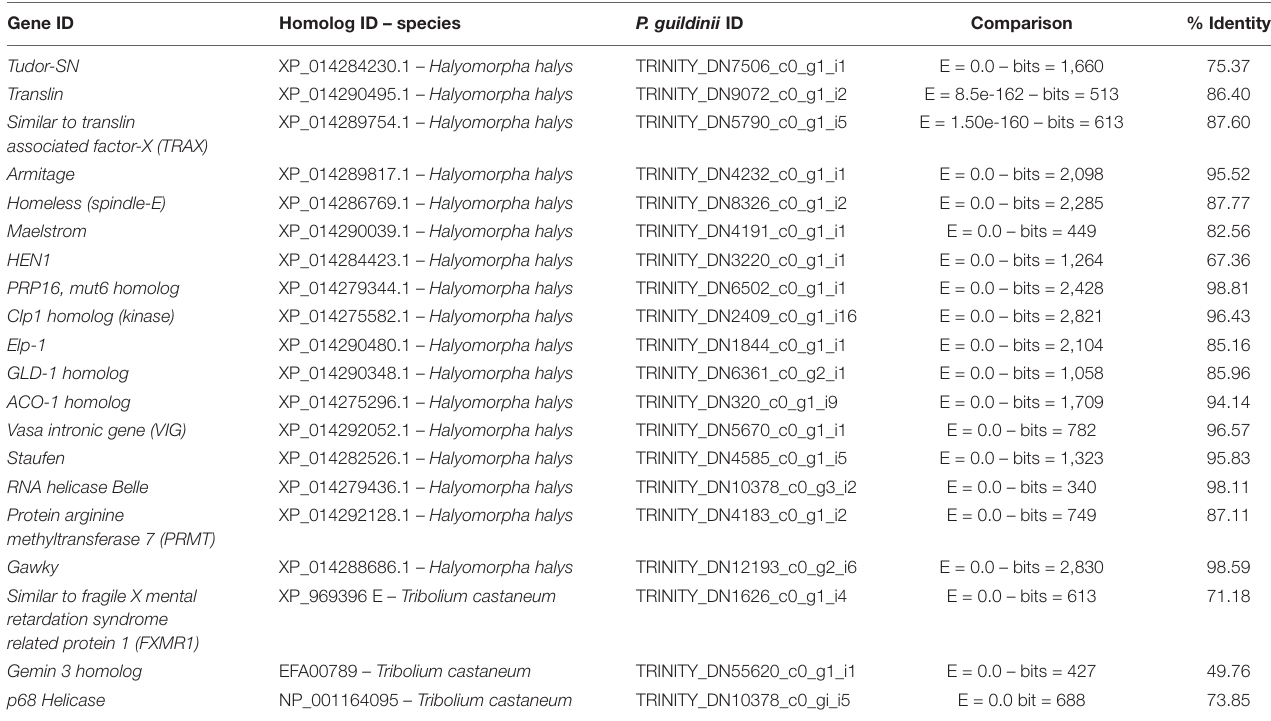
TABLE 2 | RISC-related genes identified in Piezodorus guildinii